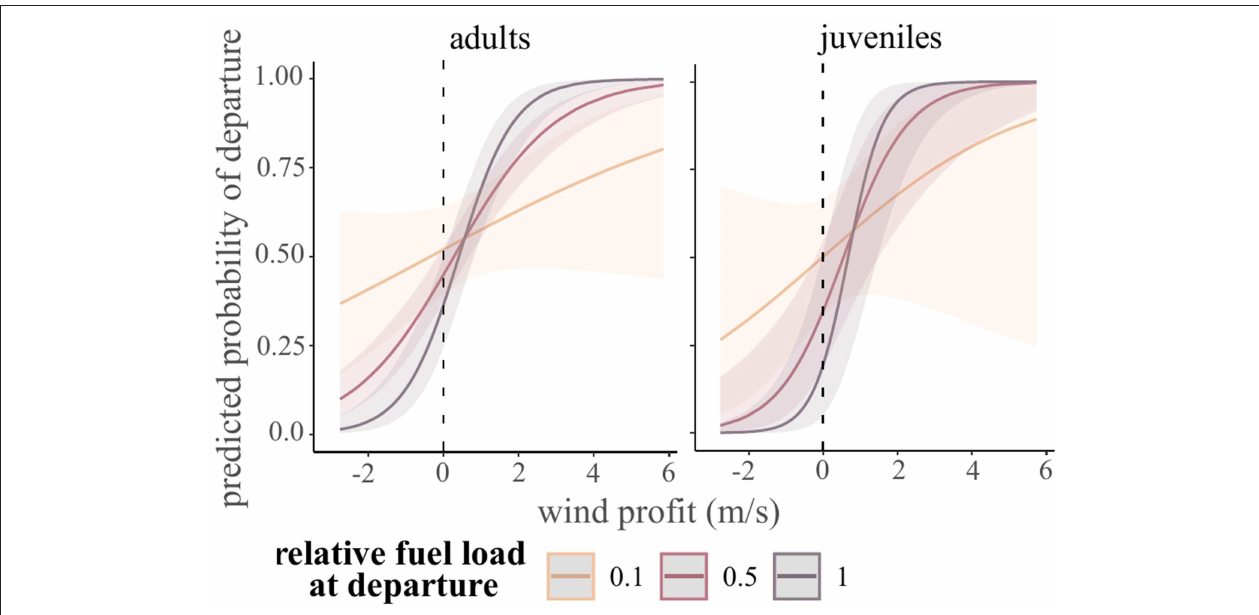
FIGURE 4 | Model predicted departure probability for shorebirds during stopover in James Bay, Ontario, Canada in 2014–2017. For clarity, the continuous variable of relative fuel load at departure is plotted at 0.1 (low), 0.5 (moderate), and 1 (high fat load). The dashed line indicates a threshold for favorable ( + ) and unfavorable winds